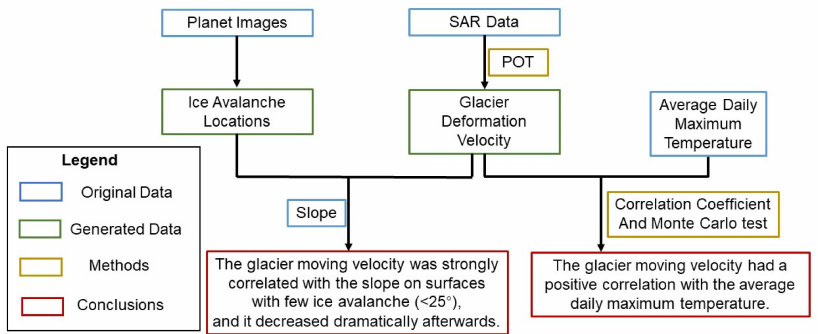
Figure 7. General flowchart of this